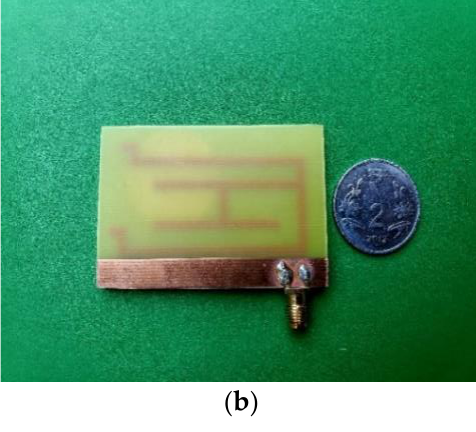
Figure 3. Fabricated monopole antenna. ( a ) Top view ( b ) Back view. (a)